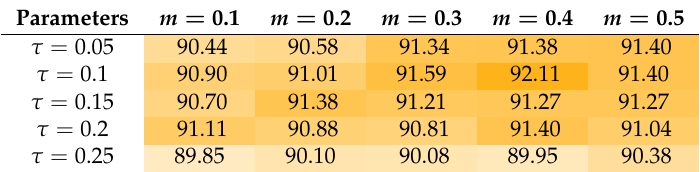
Table 5. Analysis of the τ and m parameters on the AID